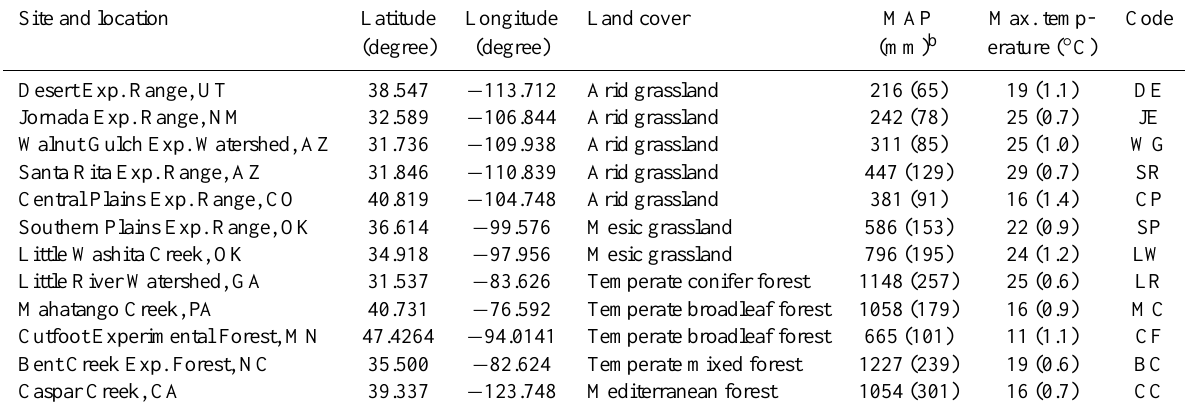
Table 1. Descriptions of the sites in this study a . Site and